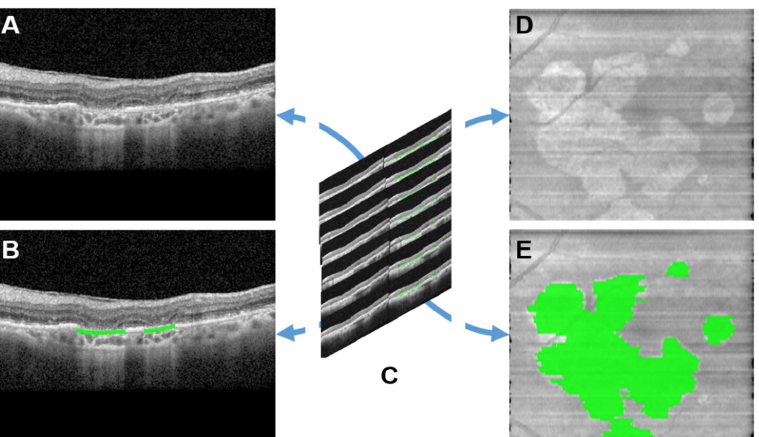
Figure 2. GA ground truth masks as created for ( A , B ) Individual B-Scans by obtaining EZ-RPE- Bruchs membrane overlap; ( C ) En face images compiled using individual B-Scans; ( D , E ) GA en face ground truth masks generated for model training. GA: Geographic Atrophy; EZ: Ellipsoid Zone; RPE: Retinal Pigment Epithelium. Raw images shown were captured using Spectralis HRA+OCT (Heidelberg Engineering, Heidelberg, Germany) with the 97 B-scan macular cube protocol.